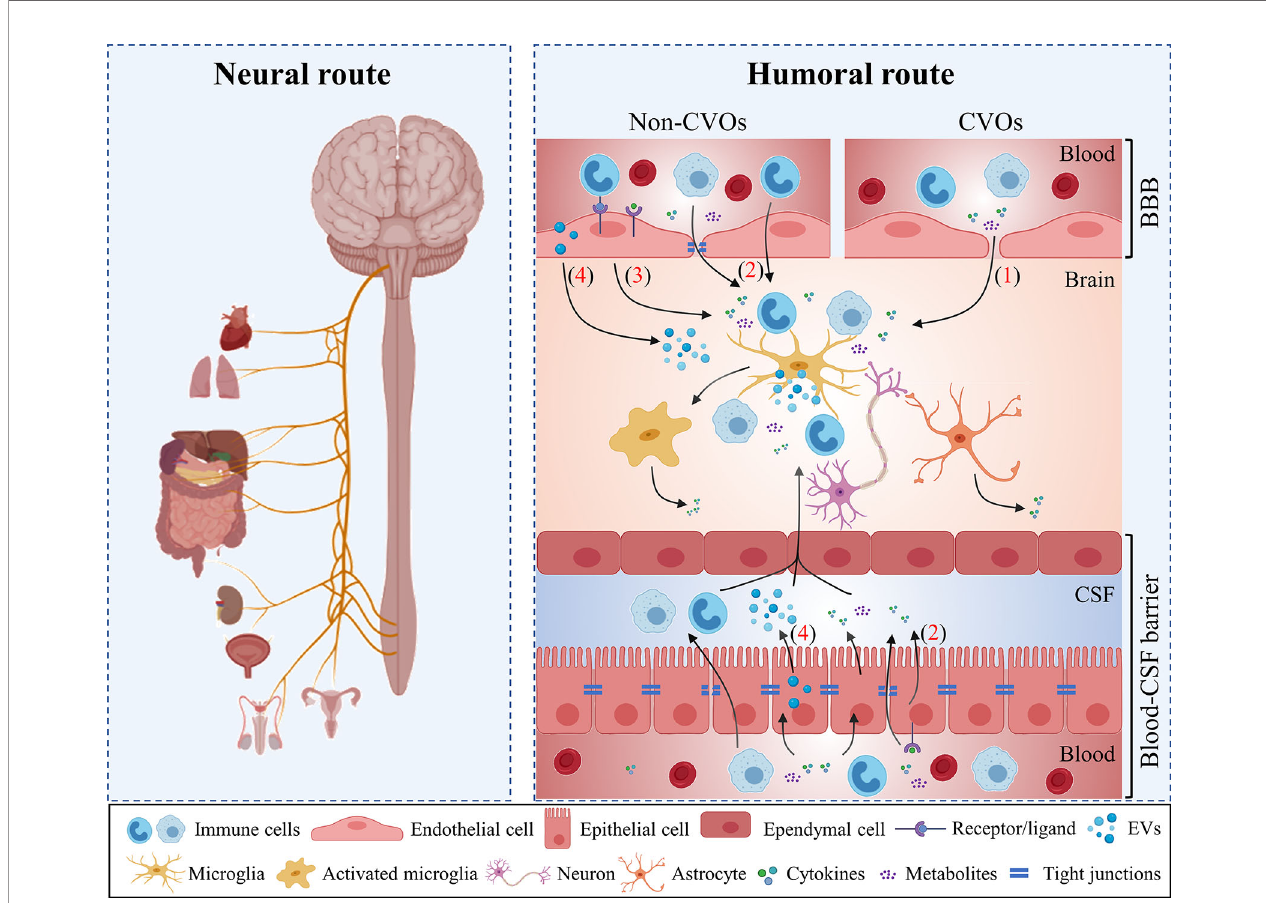
FIGURE 1 | Periphery-to-brain communication pathways. The periphery can communicate to the brain via neural and humoral routes. Peripheral organs project signals to varied cerebral regions via the vagus nerve (the neural route). Additionally, different humoral routes are used by the periphery to communicate to the brain: (1) Circulating immune mediators access the brain via the circumventricular organs (CVOs); (2) Peripheral immune cells cytokines and metabolites interact with their transporters on cerebral endothelial cells and choroid plexus epithelium (CPE) cells and subsequently enter to the brain; (3) Periphery-to-brain communication can occur via cell-mediated interactions between peripheral signals and brain cells which in turn lead to microglial activation and neuroin fl ammation. (4) Peripheral immune mediators activate choroid plexus epithelial cells and induces the release of extracellular vesicles (EVs). EVs enter the brain and can be engulfed by microglia to induce pro-in fl ammatory response. BBB, blood-brain barrier; CPE, choroid plexus epithelium; CVOs, circumventricular organs; CSF, cerebrospinal fl uid; EVs, extracellular